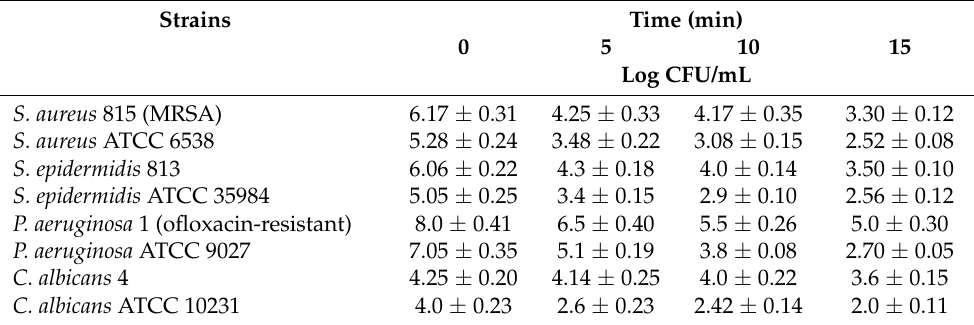
Table 1. Effectiveness of colloidal solution against microbial strains in planktonic phase. Data are the means of Log CFU/mL ± SD of three independent experiments carried out in triplicate. Strains Time (min)